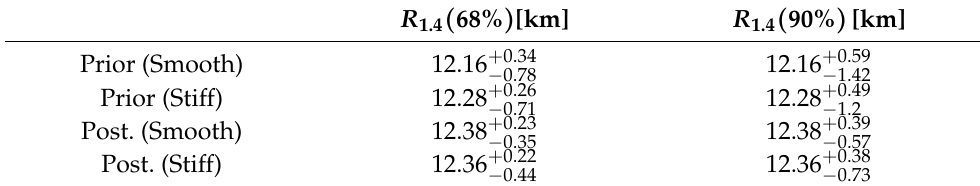
Table 2. The 68% and 90% credibility ranges for R 1.4 associated with the smooth and maximally-stiff high-density priors as well as the two posteriors accounting for all likelihood functions included in this work.